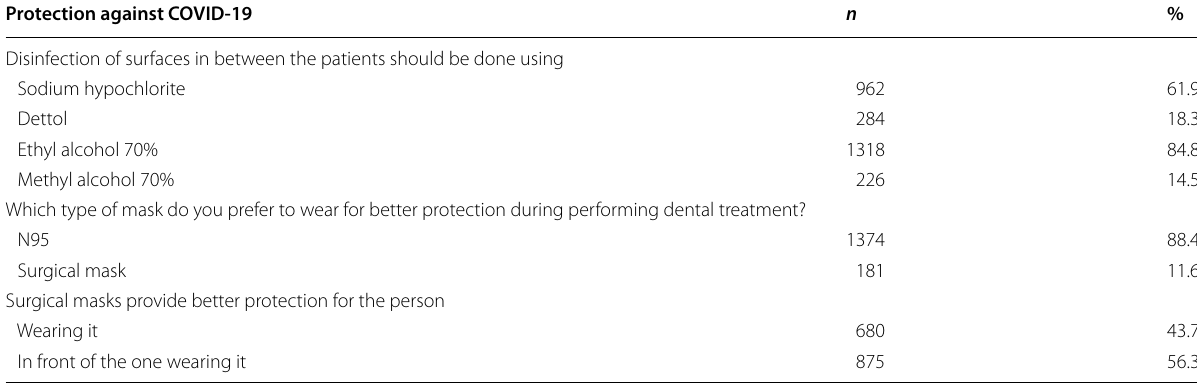
Table 3 Frequencies ( n ) and percentages (%) for answers regarding protection against COVID-19 Protection against COVID-19